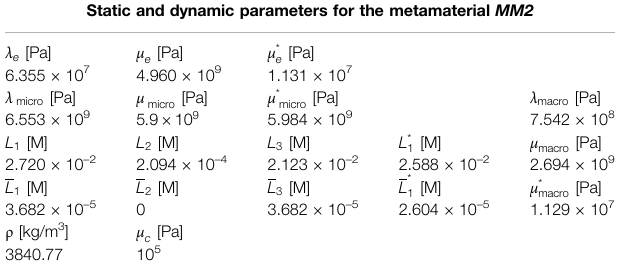
TABLE 2 | Static and dynamic parameters for the metamaterial MM2 . Panel (A) shows the values of the relaxed micromorphic static and dynamic parameters for microstructureof Figure2C .Panel (B) showsthevaluesoftheequivalentCauchy continuum elastic coef fi cients corresponding to the long-wave limit of MM2 computed with the procedure explained in (Neff et al.,